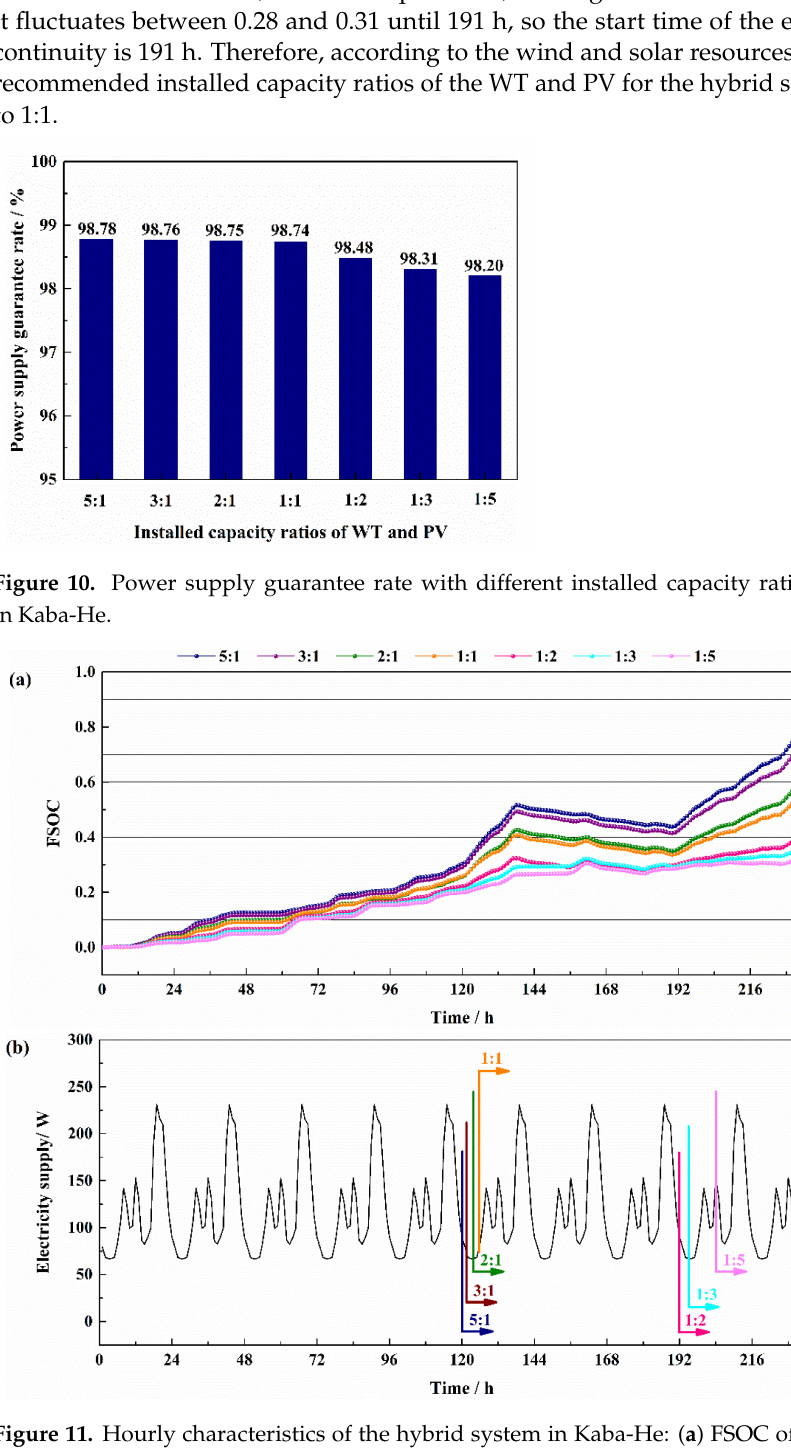
Figure 11. Hourly characteristics of the hybrid system in Kaba-He: ( a ) FSOC of the first ten days; ( b ) the start time of electricity supply continuity with different installed capacity ratios of WT and